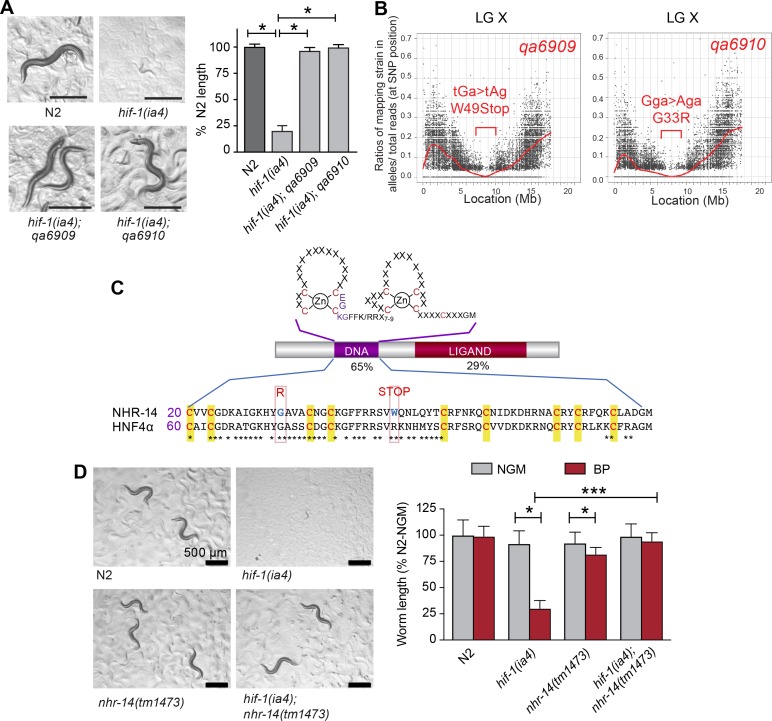
Mutations in nhr-14 rescue the low iron developmental delay in hif-1(ia4) mutants.(A) Representative images of wild-type N2 worms, hif-1(ia4) mutants and hif-1(qa6909) and hif-1(qa6910) mutant alleles grown for 5 days on NGM plates containing 25 uM BP (bipyridyl, iron chelator). Worm length is expressed as a percentage of wild-type N2 length (n = 2 biological replicates with 10 worms per strain). Values are expressed as mean ± SEM and were compared by unpaired two-tailed Student’s t-test, *p<0.05. (B) CloudMap SNP Mapping are shown as XY-scatter plots where the ratio of Hawaiian SNPs to Bristol SNPs is represented for the qa6909 and qa6910 mutations. (C) Protein alignment of the DNA-binding domains for human HNF4α and NHR-14 with locations of the qa6909 and qa6910 mutations (adapted from Figure 1 from Antebi, 2006, published under the terms of the Creative Commons Attribution License – CC-By 2.5 license; https://creativecommons.org/licenses/by/2.5/). Amino acid mutations are indicated in red. (D) Representative images of wild-type N2, hif-1(ia4), nhr-14(tm1473) and hif-1(ia4); nhr-14(tm1473) worms grown in NGM or NGM-25 uM BP (low iron) after 5 days. Worm length is expressed as a percentage of wild-type N2-NGM length (one experiment, n = 20 - 30 worms per strain). Values are expressed as mean ± SEM and compared by two-way ANOVA with Tukey’s multiple comparisons test, *p < 0.05; ***p < 0.001. Scale bars, 500 um.